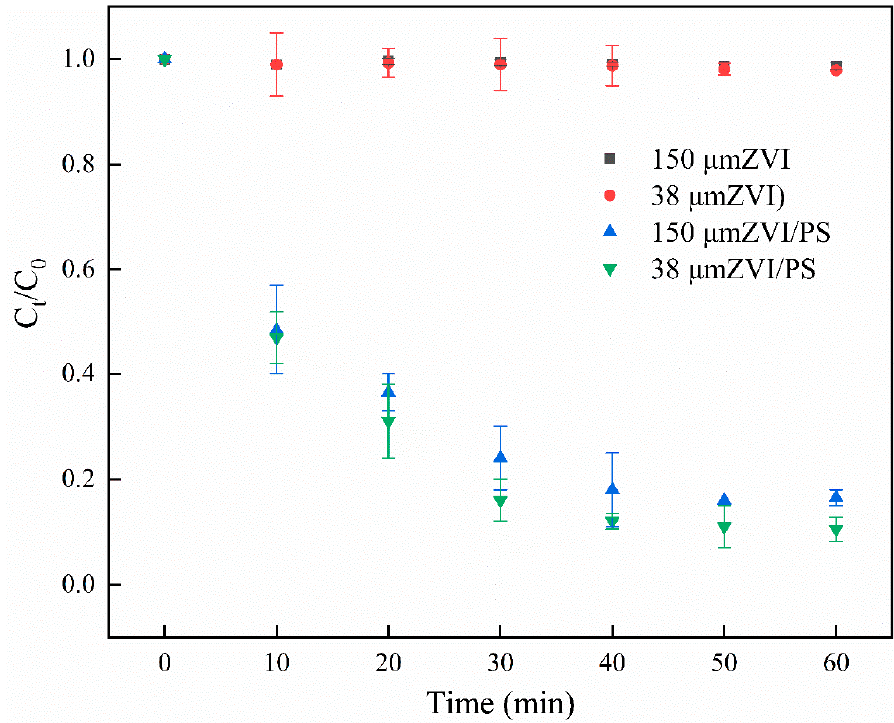
Figure 4. The degradation of pyrene under two sizes of ZVI. Experimental conditions: [PS] = 21 mM; [ZVI] = 3 g/L; 25 °C, 160 rpm; no pH